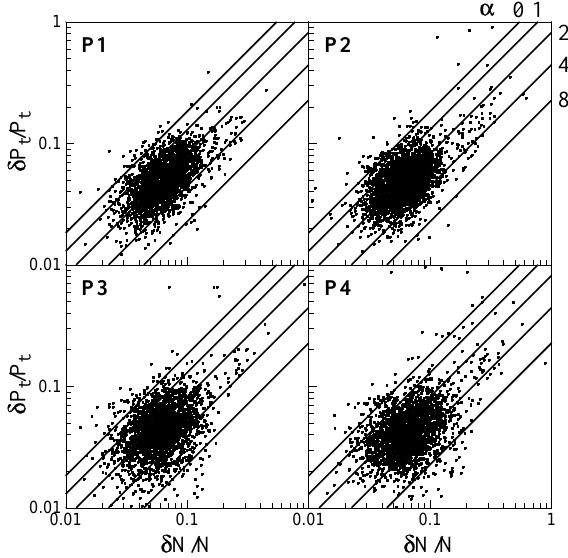
Fig. 10. Scatter plots of the relative amplitudes of thermal vs. mag- netic pressure fluctuations for polar wind samples P1 to P4.